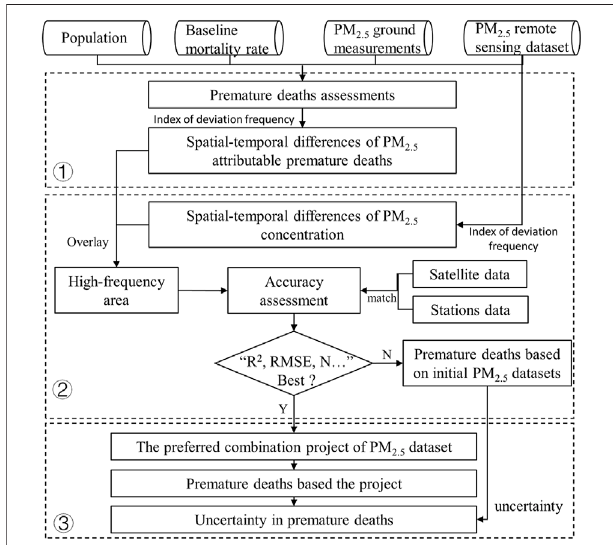
FIGURE 2 | Technical fl owchart of this study.